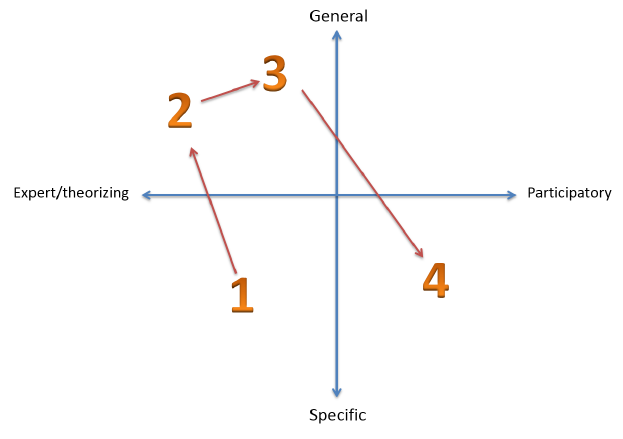
Fig. 2 . Fraser’s research